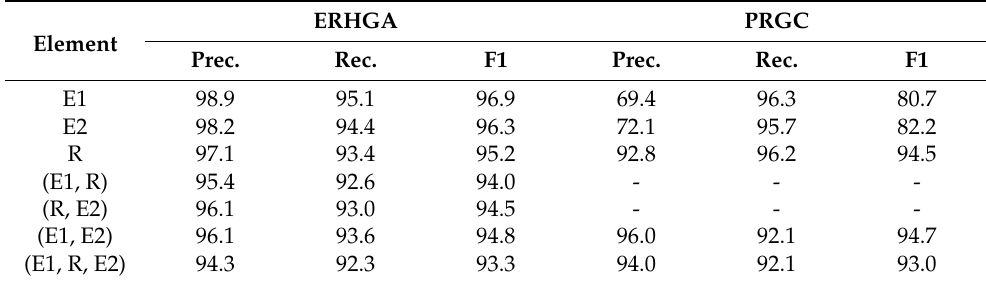
Table 8. Results (%) of relational triple elements on ERHGA and PRGC.